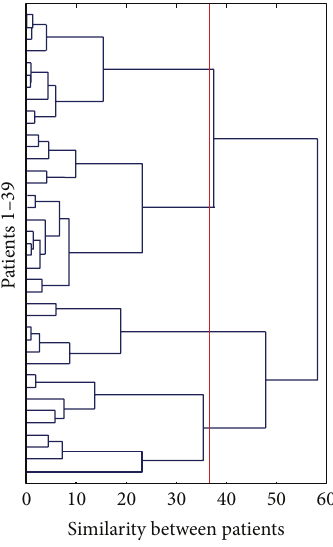
Figure 1: The dendrogram generated by the cluster analysis. Each patient ( 𝑁 = 39 ) begins as single clusters and step-by-step the most similar clusters are progressively joined together resulting at the end of the process (in the right-most part of the figure) in a single cluster grouping all the patients. The distance along the 𝑥 -axis represents a measure of similarity between the patients; the vertical red line represents the linkage chosen to select the